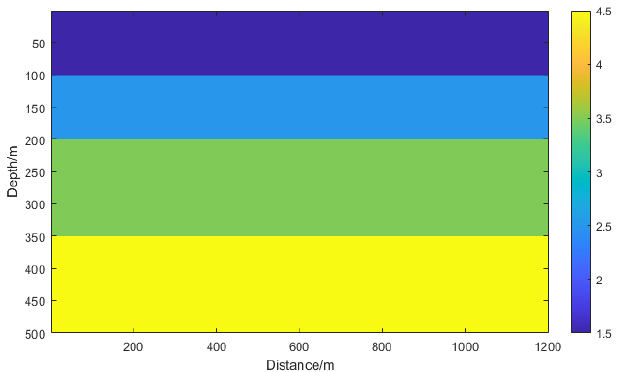
Figure 1. Simple ‐ layered model. Figure 1. Simple-layered